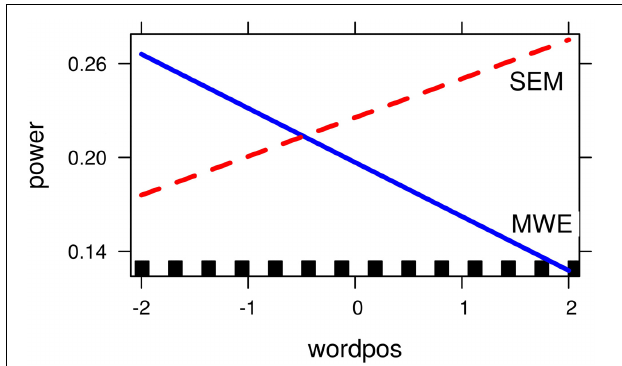
FIGURE 3 | Word-position by condition interaction for Alpha/Theta band model (6–9Hz). Axis show transformed values for the dependent and independent variable: logarithm for the relative power values, and centered values for word